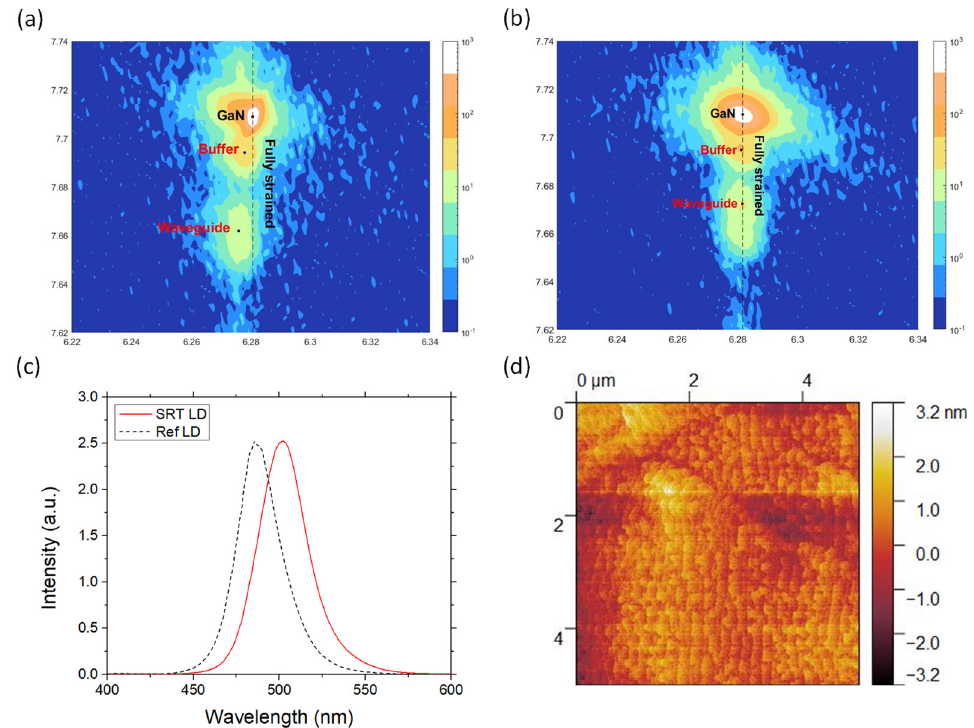
Figure 2. RSM of ( a ) SRT LDs: a 26.6% relaxed In x Ga 1 − x N buffer and a 16.1% relaxed In y Ga 1 − y N waveguide, with x = 0.015 and y = 0.043, respectively; and ( b ) reference LDs: the InGaN buffer and waveguide are both strained to GaN. ( c ) EL spectra at 20 A/cm 2 for SRT LDs and reference LDs, where the former show a 16.9 nm red shift. ( d ) A 5 by 5 µm 2 AFM scan on the top surface of the epi structure, showing a smooth morphology with an RMS roughness of 0.65 nm .